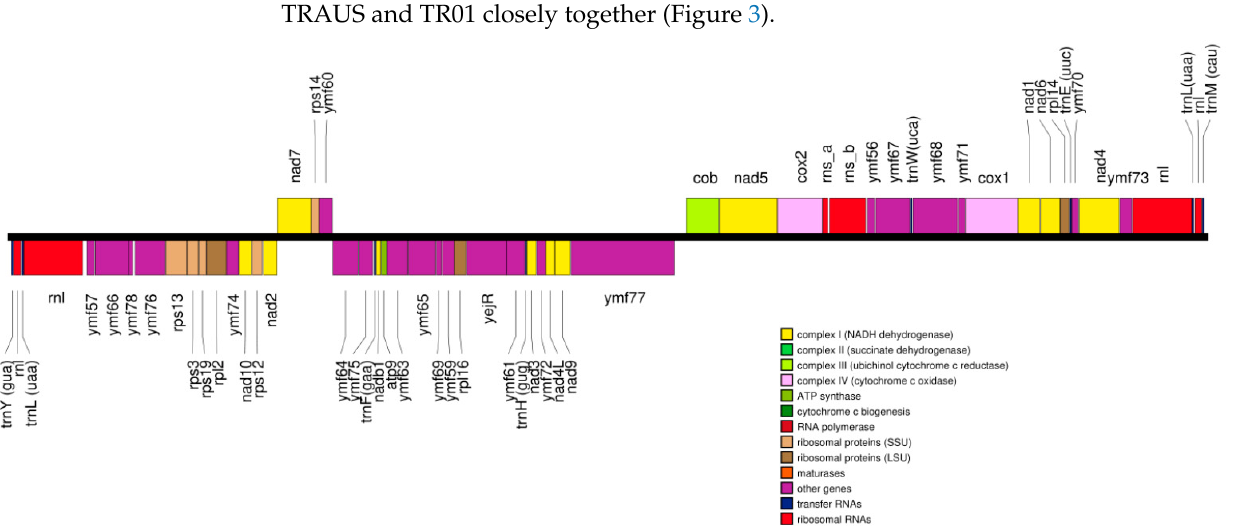
Microorganisms 2021 , 9 , 2100